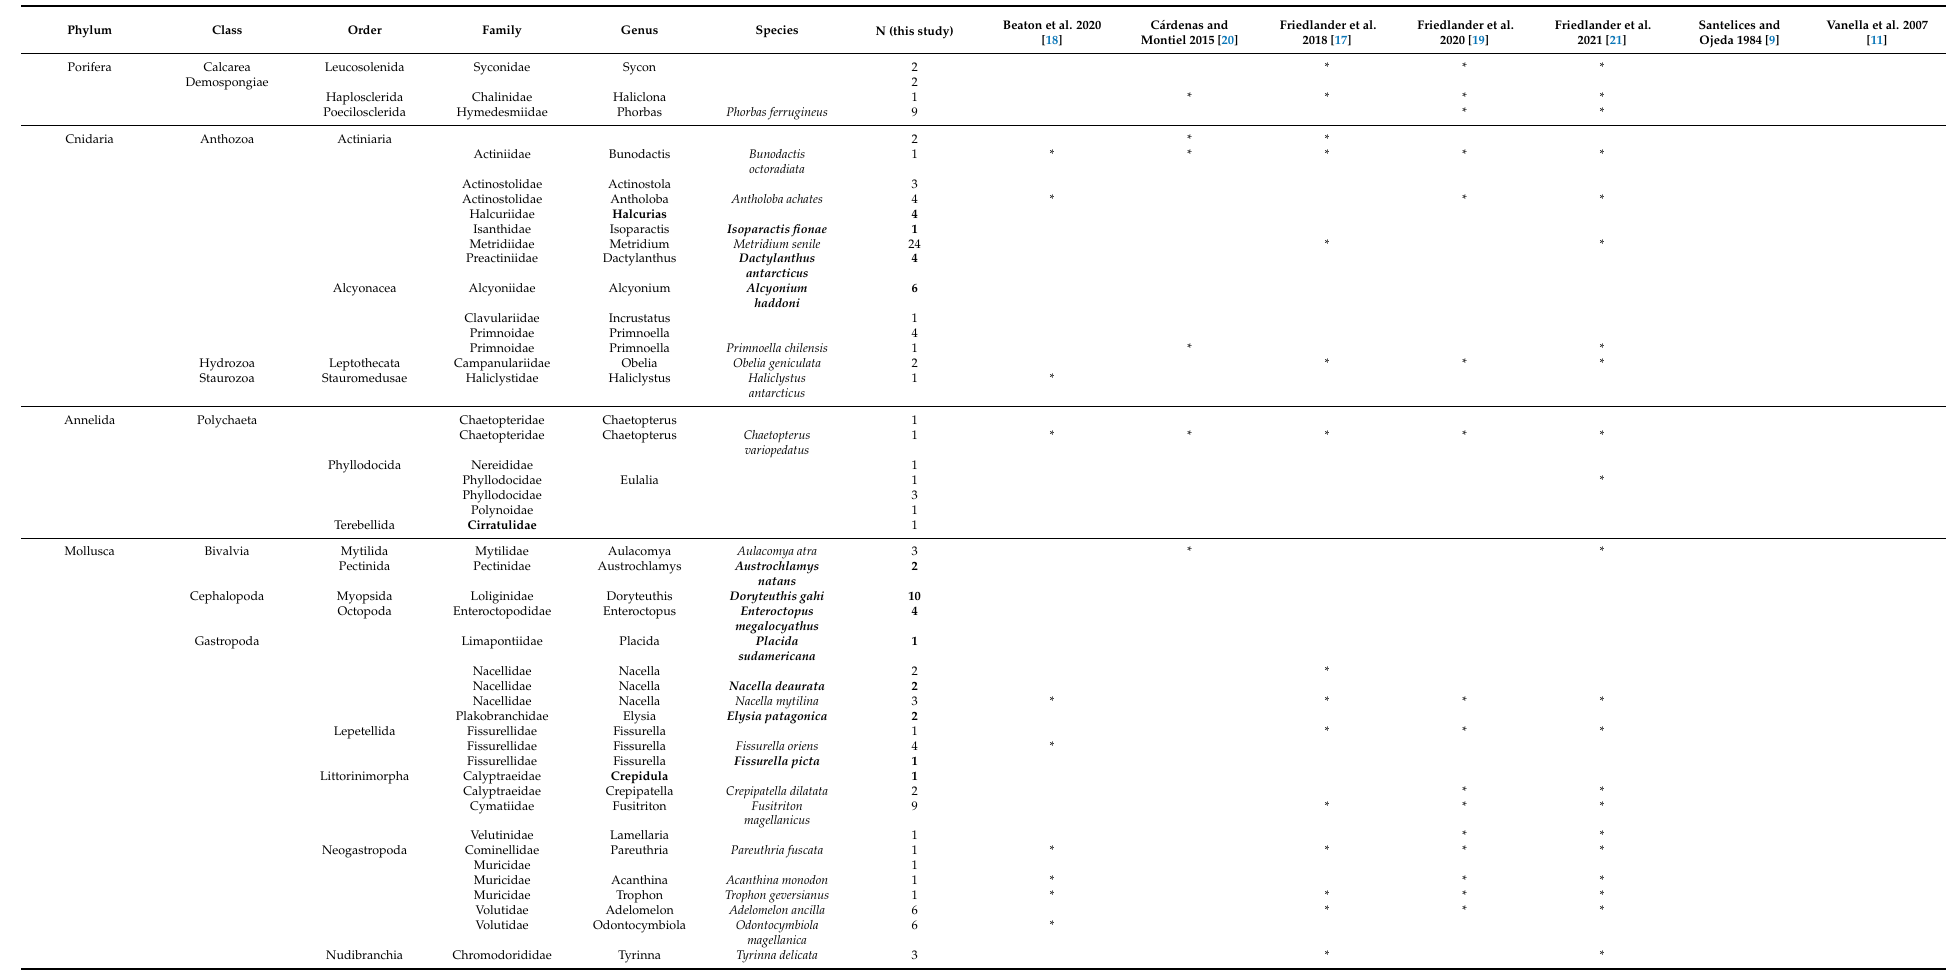
Table 1. List of marine species found during this study with indication of the number of observations (N) with associated photograph and those taxa recorded by other studies in the region (*). Bold letter indicates “unique” records (family, genus, or species) found in our study. N for taxa higher than species corresponds to specimens not possible to be determined to specific